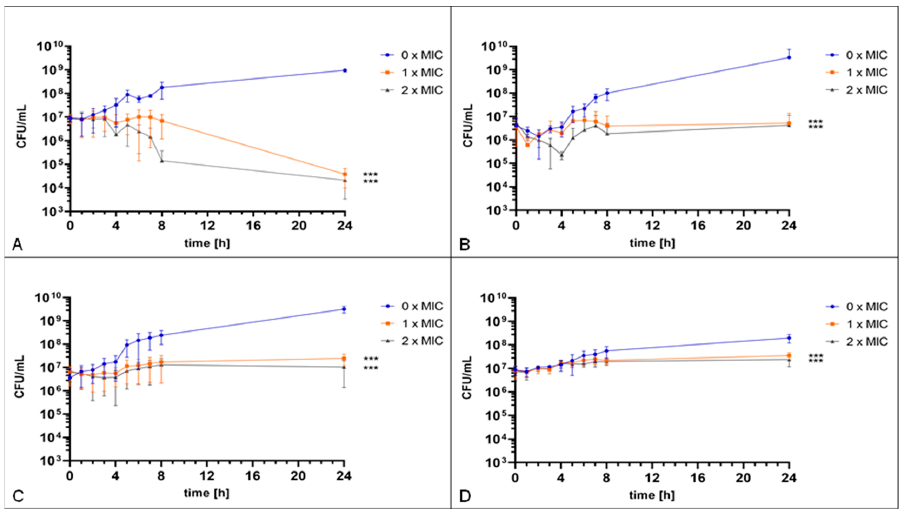
Figure 2. Time–kill assay. The reference strain K279a ( A ) and Sm 538 ( C ) were incubated with 0 mg/L, 4 mg/L, and 8 mg/L gepotidacin. The strain Sm 290 ( B ) was incubated with 0 mg/L, 1 mg/L, and 2 mg/L gepotidacin, while the strain Sm 1222 ( D ) was incubated with 0 mg/L, 2 mg/L, and 4 mg/L gepotidacin. CFU/mL were determined hourly over the first eight hours and after 24 h. Observed growth after incubation without gepotidacin (blue), with one ‐ fold MIC (orange) and two ‐ fold (grey) gepotidacin. Significance levels are shown by asterisks: ***: p < 0.001 and determined via two ‐ way ANOVA using GraphPad Prism.